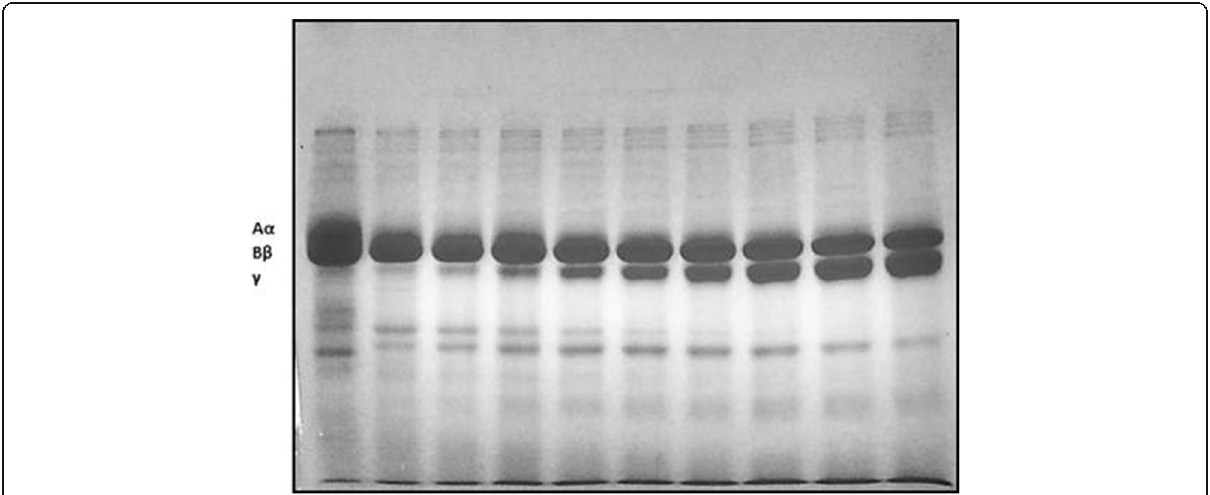
Fig. 4 Time-dependent fibrinogenolysis by SCF. SCF (4 μ g/ml) was incubated with 2 mg/ml of fibrinogen for varied time periods to test the time required by 4 μ g/ml SCF to digest fibrinogen. Numbers on each lane indicate incubation time periods in hours. C = fibrinogen incubated with